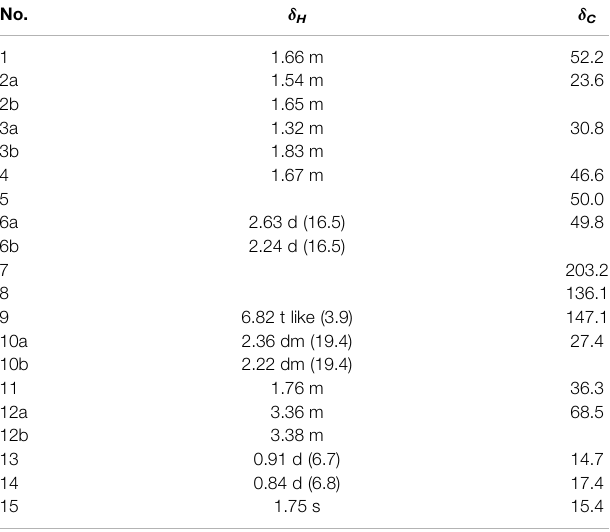
TABLE 1 | 1 H and 13 C NMR data for 1 (Record in CD 3 OD, J in Hz). No. δ H δ